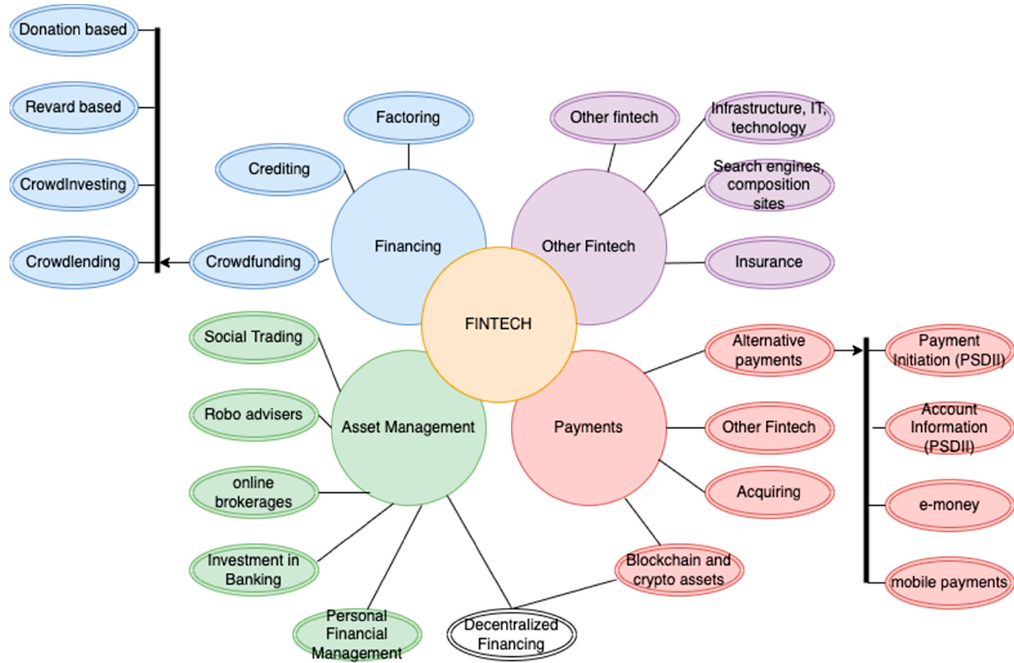
Figure 1. Fintech segmentations. Source: generated by the authors.